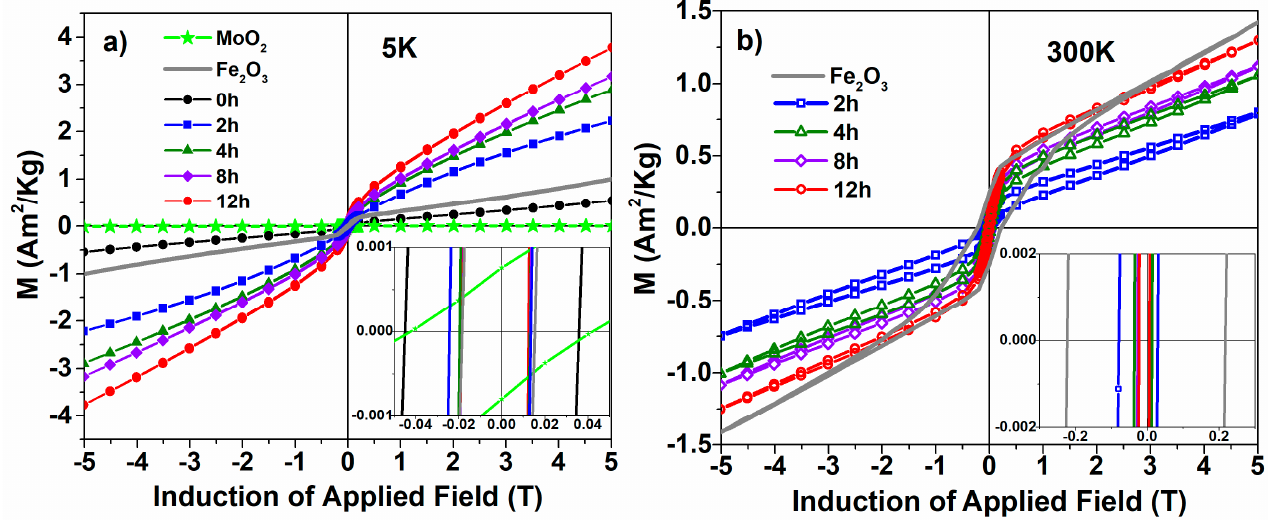
Figure 3. Hysteresis curves recorded ( a ) at 5 and ( b ) at 300 K. Insets: zoomed view of coercivity. An interesting feature, revealed by the zoomed view of the coercive field domain from Figure 3, is the field asymmetry of the hysteresis loops, both at 5 and at 300 K, suggesting enhanced unidirectional anisotropy effects. This led us to measure the hysteresis curves also after cooling the sample in 5 T. Figure 4a shows the hysteresis loops recorded at 5 K, for the sample subjected to milling for 2 h, after cooling without and respectively in the 5 T applied field. Figure 4b shows the hysteresis curves measured after FC of the 2 h